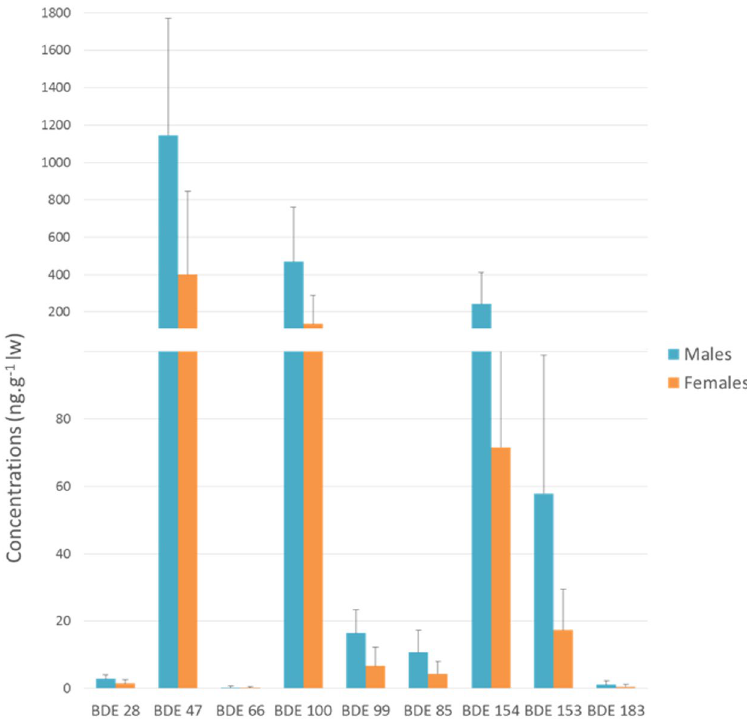
Figure 4. Mean concentrations (and standard deviations) of Ʃ PBDEs (ng.g − 1 lw) in blubber biopsies of bottlenose dolphins from the Normanno-Breton Gulf.